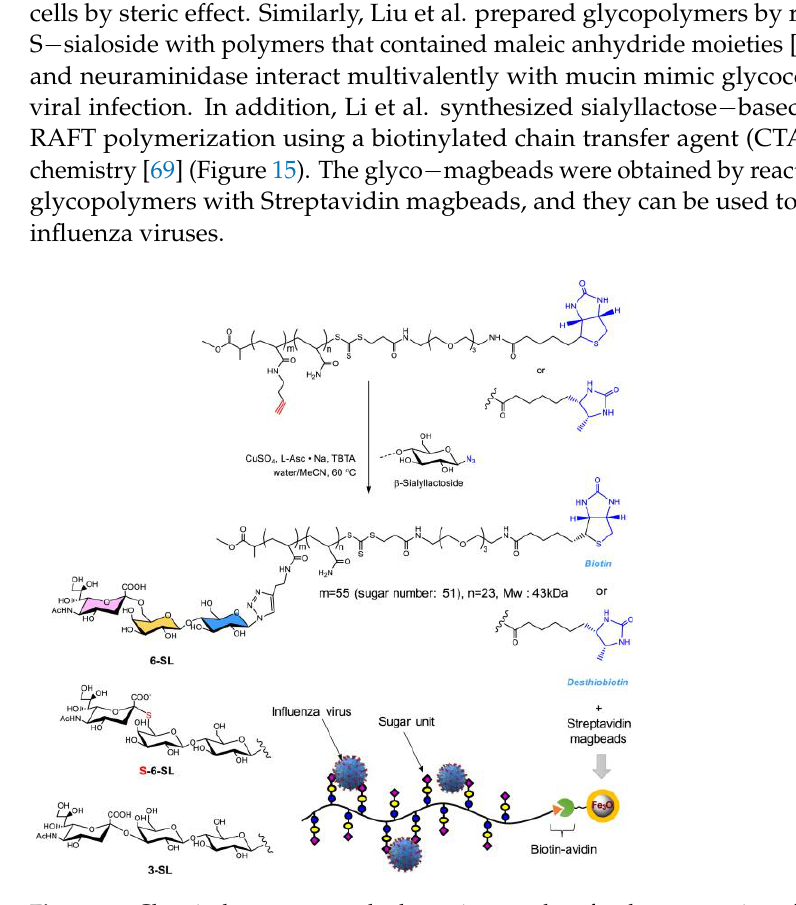
Figure 16. Construction of a synthetic scheme for multivalent glycopolymer containing SLac part. Figure reproduced from ref. [71] with permission. In addition, the topology of the glycopolymers has a significant impact on the bind- ing ability of viruses. As shown in Figure 17, Nagao et al. synthesized a three − arm